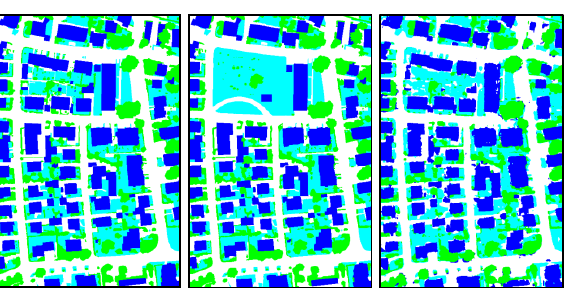
Figure 6. Vaihingen, area 3. Left: reference; centre: simulated database; right: classification results (LN). The colour code is identical to figure